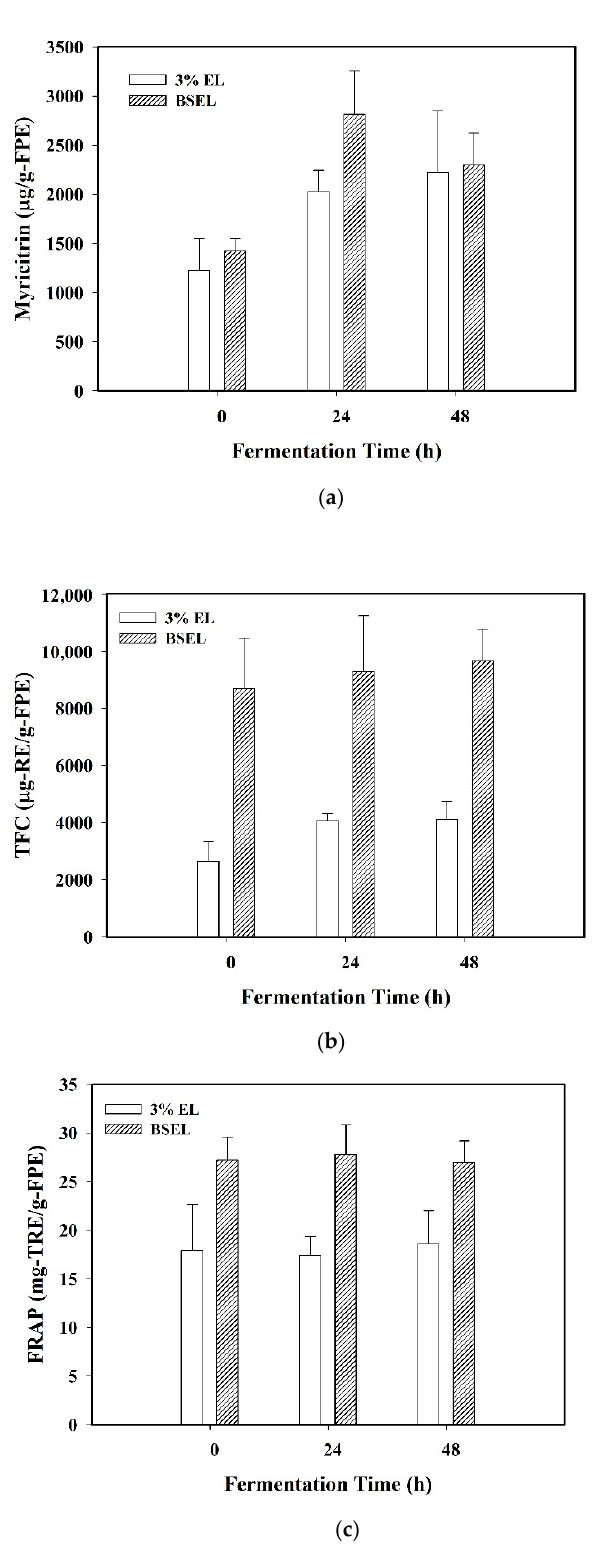
Figure 4. Comparison of ( a ) myricitrin content, ( b ) total flavonoid content (TFC), and ( c ) ferric reducing antioxidant power (FRAP) of the fermented product extract (FPE) at 0, 24, and 48 h of fermentation for the medium 3% EL in MRS (3% EL) and the medium 3% EL in black soymilk (BSEL). The data were expressed as mean ± standard deviations ( n = 3). By using BSEL as the medium, the content of myricitrin in the fermented product extract was 2297.06 ± 328.35 μ g/g-FPE at 48 h, which was 1.61 fold that (1426.61 ± 119.96 μ g/g-FPE) at 0 h with a significant increase. The myricitrin content (2817.17 ± 435.51 μ g/g- FPE) at 24 h was higher than that at 48 h, but with insignificant difference (Table S5), showing that the 24-h fermentation time was sufficient for the extraction of myricitrin from EL by the black soymilk. Using BSEL, the TFC in the fermented product extract was slightly increased with increasing fermentation time, but with insignificant difference for 9643.64 ± 1120.21 μ g/g-FPE at 48 h. By using BSEL, the FRAP for the fermented product extract at 48 h was 26.98 ± 2.21 mg/g-FPE, which was insignificantly different with that at 0 and 24 h of fermentation. Undoubtedly, the FRAP values were corresponding to the TFC trend using BSEL, demonstrating that most flavonoid compounds were transported into the fermented product at 0 h of fermentation. Moreover, the FRAP and content of myricitrin and TFC in the fermented product extract at 0, 24, and 48 h by using BSEL were all greatly higher than that by using 3% EL in MRS broth. At 24 h of fermentation, the content of myricitrin and TFC, and antioxidant capacity (FRAP) with 3% EL in black soymilk were 1.39-fold, 2.29-fold, and 1.60-fold of that with 3% EL in MRS broth, respectively. This showed that, compared with MRS broth, black soymilk was able to facilitate the transport of myricitrin and other flavonoids from EL into the fermented product during the fermentation process. 3.5. Surface Morphology of Solid Substrate with L. plantarum Field emission scanning electron microscope (FE-SEM) was used to observe the col- ony morphology of the L. plantarum on the surface of E. serratus leaves using MRS or black soymilk medium before and after fermentation. The surface morphology of the solids sep- arated from the sterilized medium after inoculation of L. plantarum was observed by using FE-SEM for 0 and 48 h of fermentation time, as shown in Figure 5a–d.